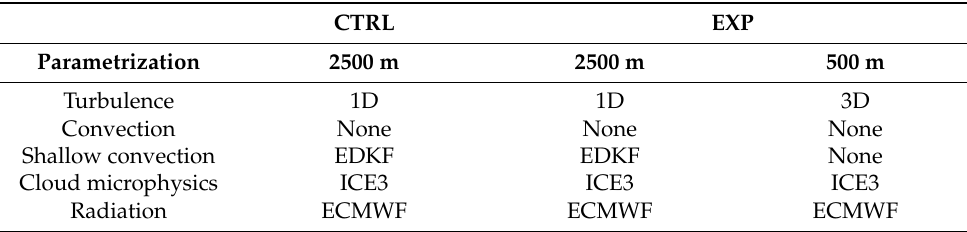
Table 1. Parametrisations schemes used in the present study by the Meso-NH model. CTRL EXP Parametrization 2500 m 2500 m 500 m Turbulence 1D 1D 3D Convection None None None Shallow convection EDKF EDKF None Cloud microphysics ICE3 ICE3 ICE3 Radiation ECMWF ECMWF